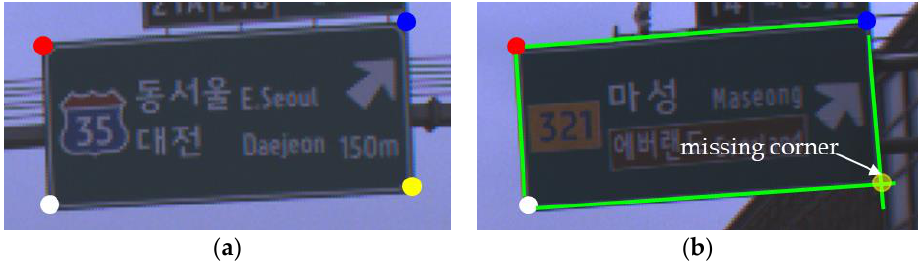
Figure 6. Examples of road sign hypotheses. ( a ) four corner combination, ( b ) three corner combination.